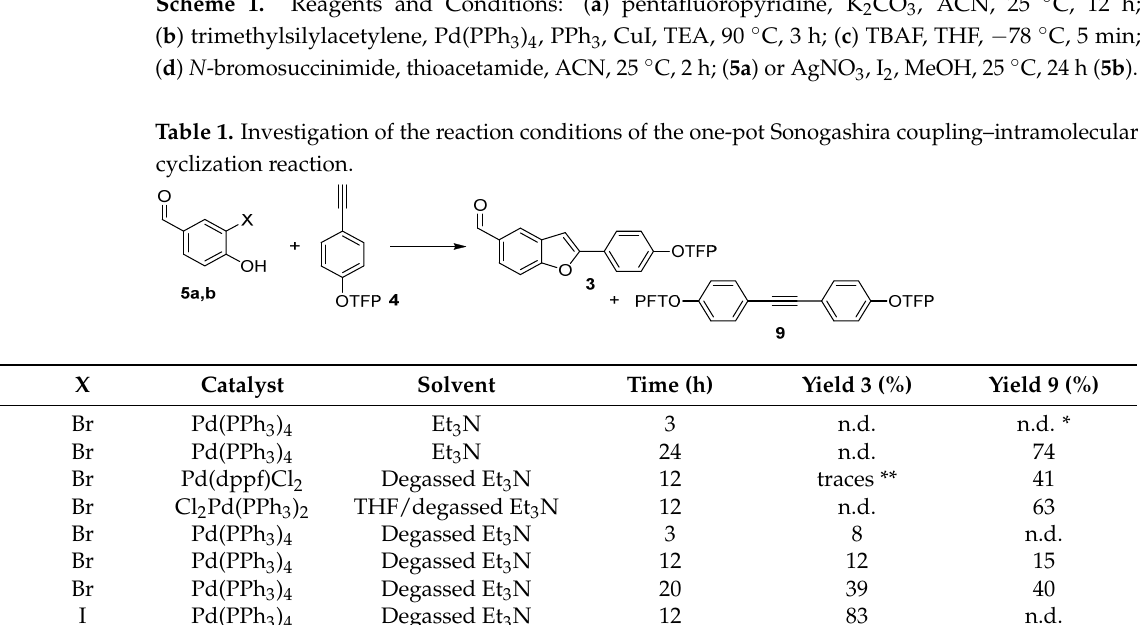
Table 1. Investigation of the reaction conditions of the one-pot Sonogashira coupling– intramolecular cyclization reaction.